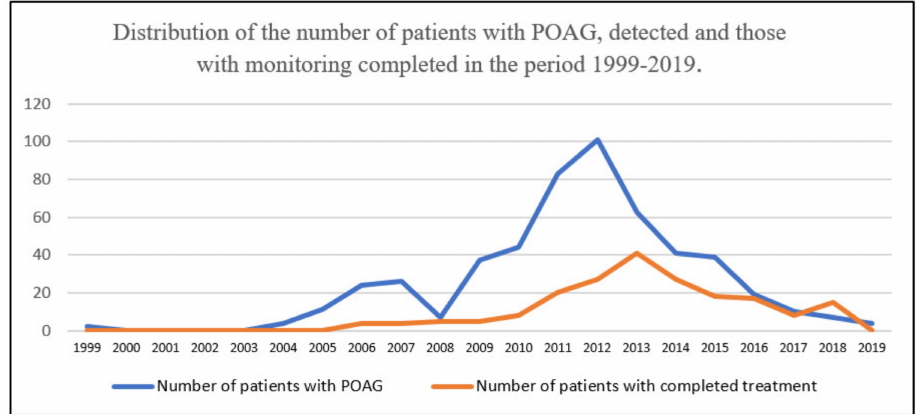
Figure 1. Distribution of the number of POAG patients detected and patients with treatment completed in the period